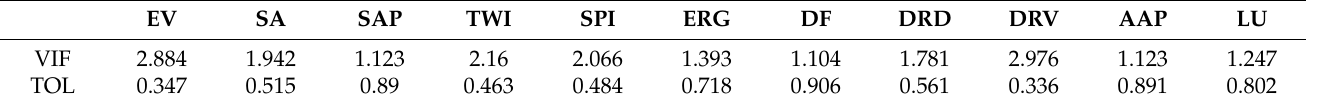
Table 4. Multicollinearity analysis of the landslide influencing factors.